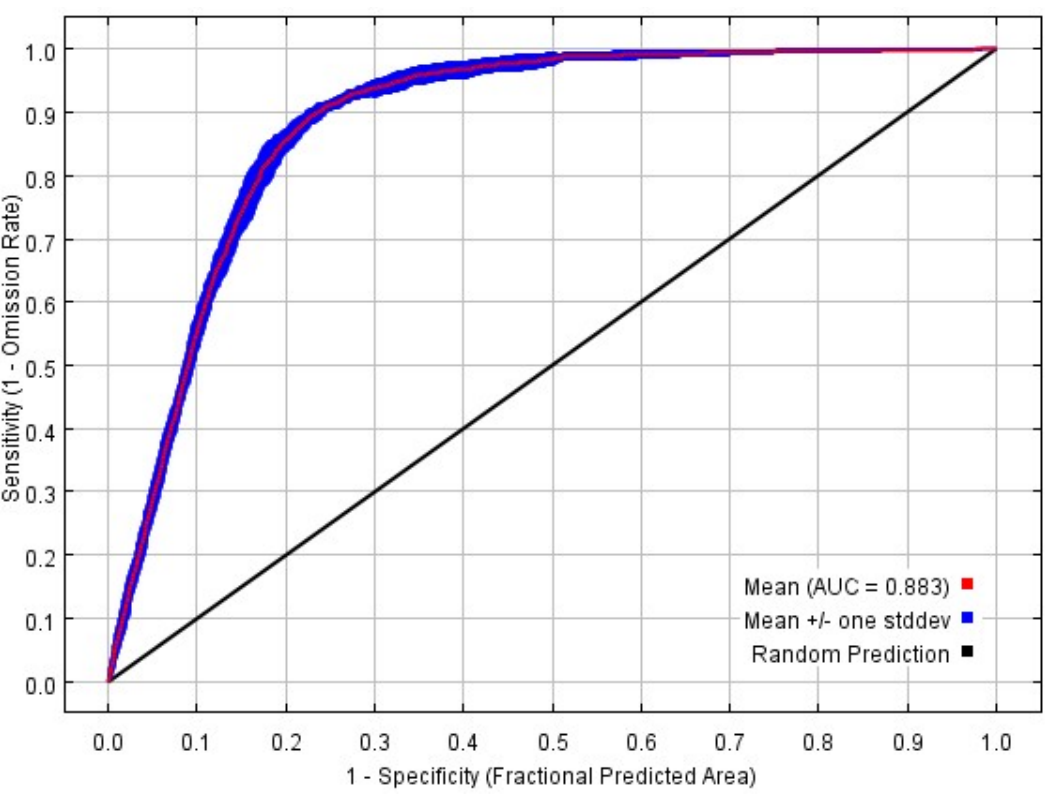
Figure 3. Mean AUC values of the Linepithema humile MaxEnt model.